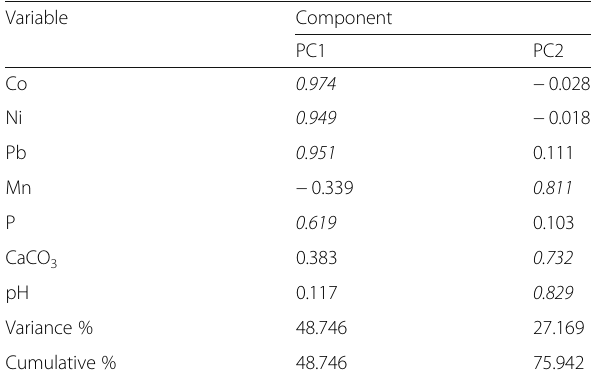
Table 3 Principal component loadings of soil data including variance % and cumulative % Variable